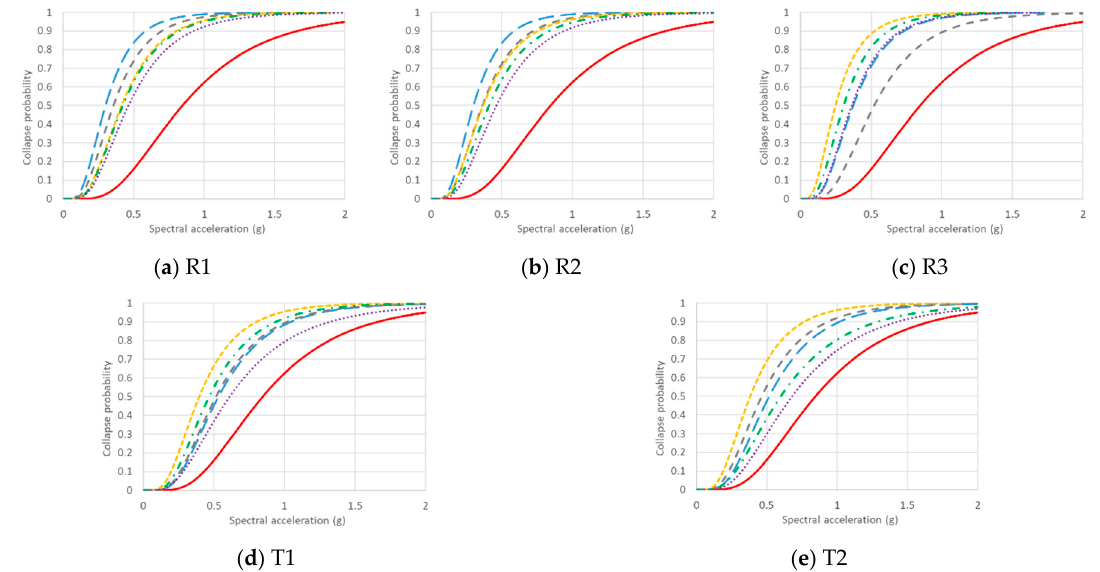
Figure 17. Seismic fragility curve for individual engineering demand parameters (EDPs) and acceptance criteria (Model A). Table 13. Primary failure mode by analysis model.